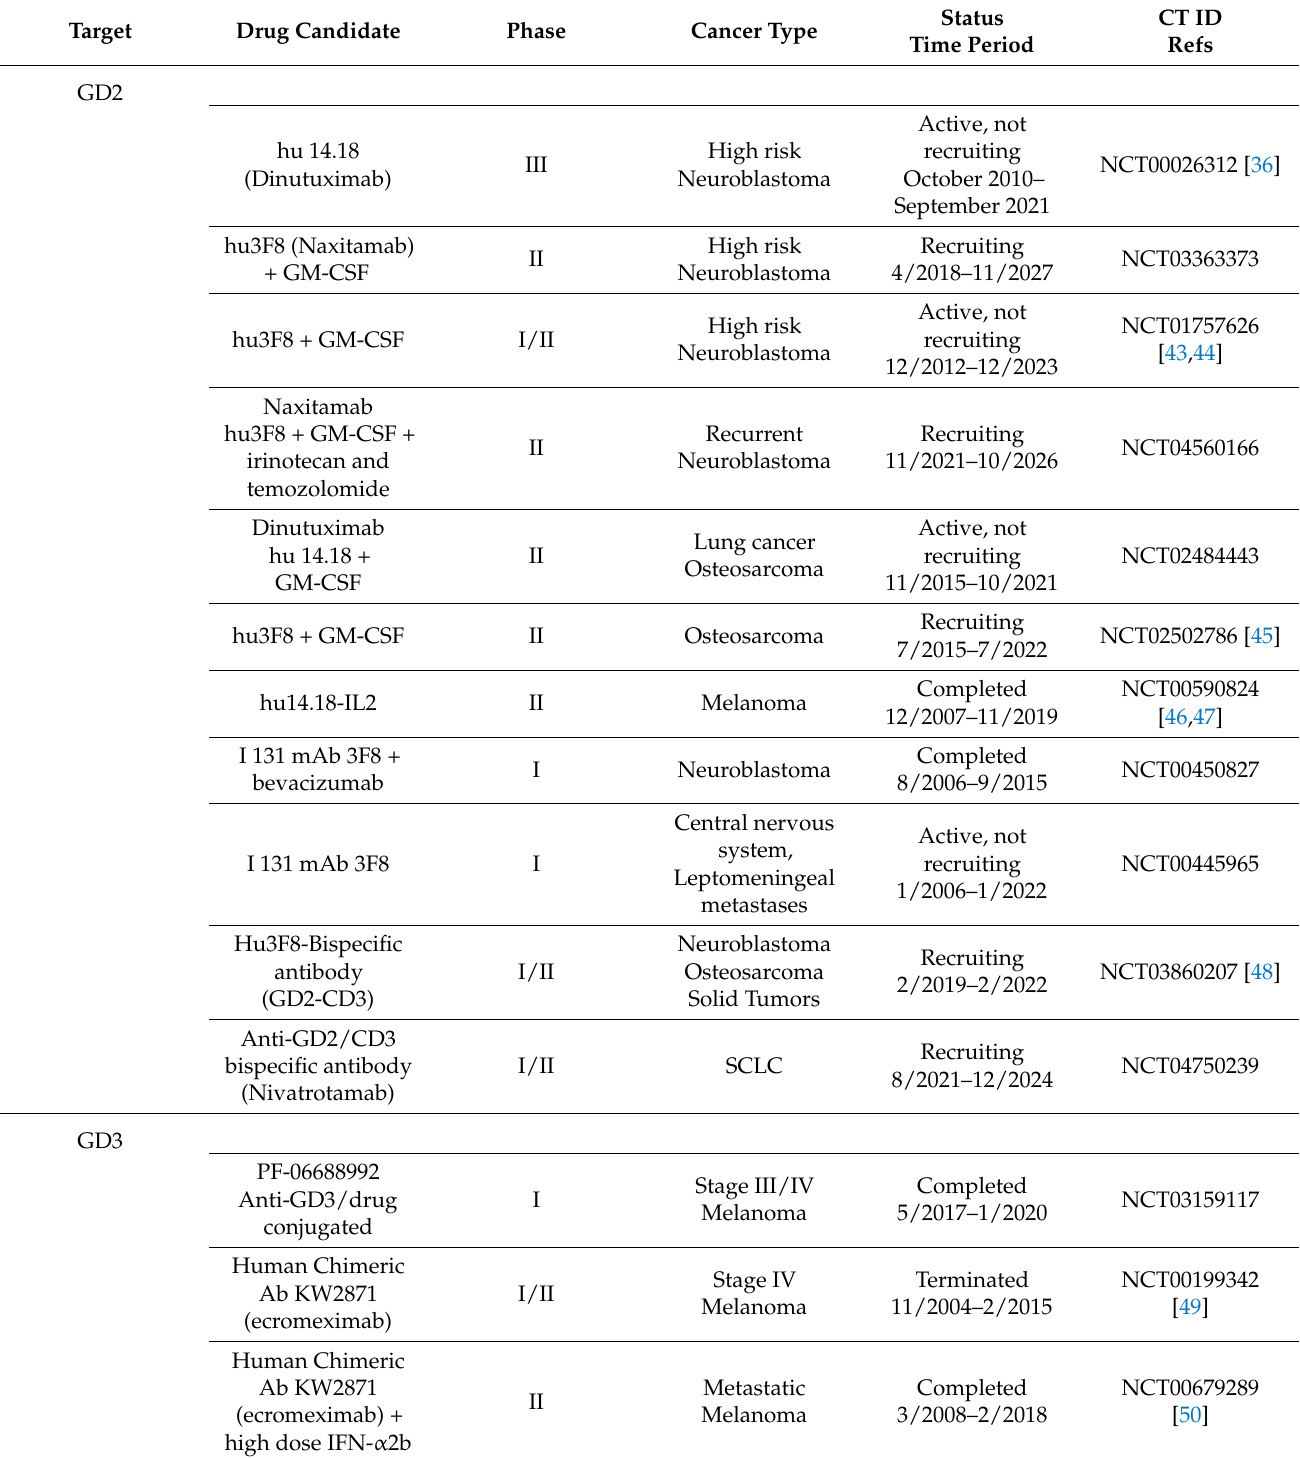
Table 2. Selected clinical trials of antibodies targeting tumor